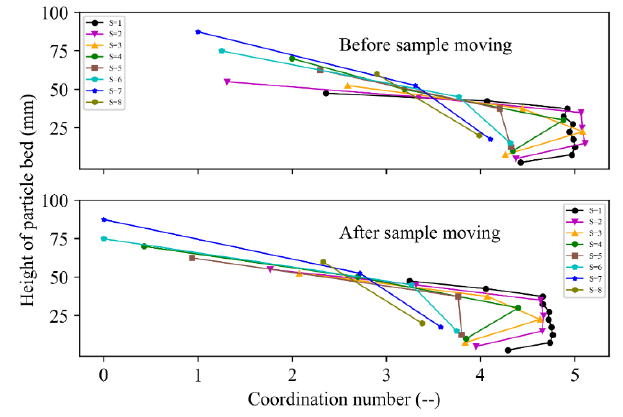
Figure 11. Coordination number distribution.